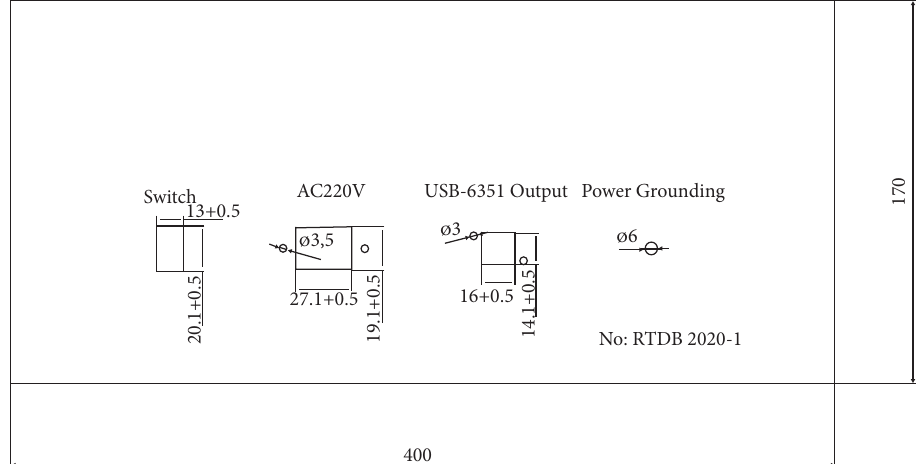
Figure 5: The back layout of the hardware panel.